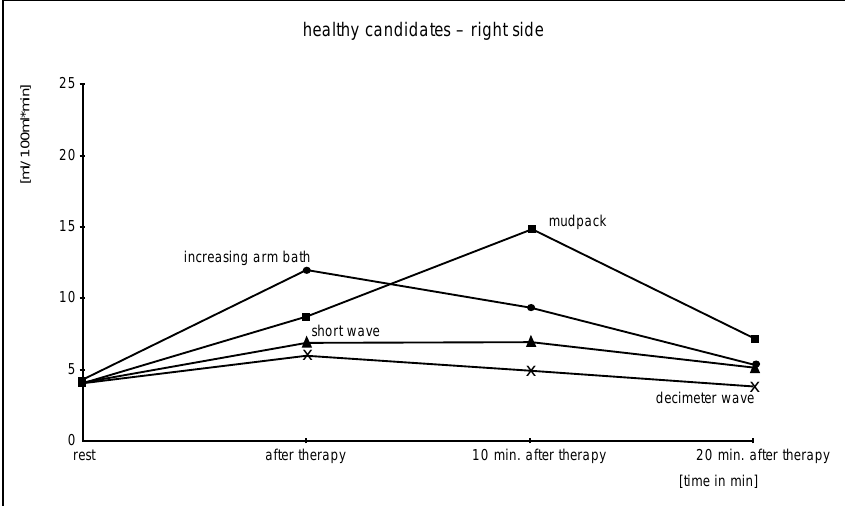
Figure 2: Forearm blood flow after application of different forms of thermotherapy in the healthy reference groups (n =